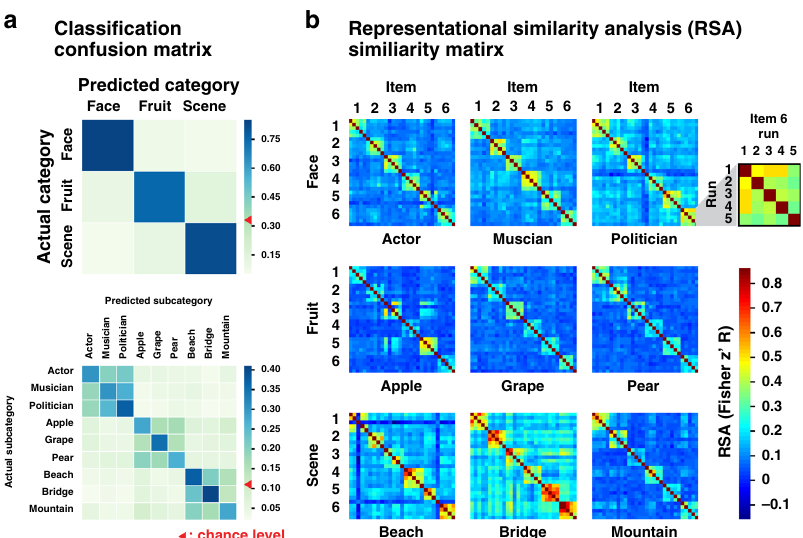
Fig. 3 WM representation multivariate pattern analysis. a Classi fi er confusion matrices for category-level classi fi cation (in the ventral visual stream, VVS) and subcategory-level classi fi cation (whole brain), b and item-level RSA (VVS) on the localizer data for N = 50 participants. Within each subcategory there were six items (e.g., six actors) each of which was shown once in each of fi ve runs. The inset provides an expanded view of the similarity matrix of the item-level RSA across the fi ve runs for a single item (item 6 from the politician subcategory). See Supplementary Table 2 for the statistics. Source data are provided as a Source Data fi